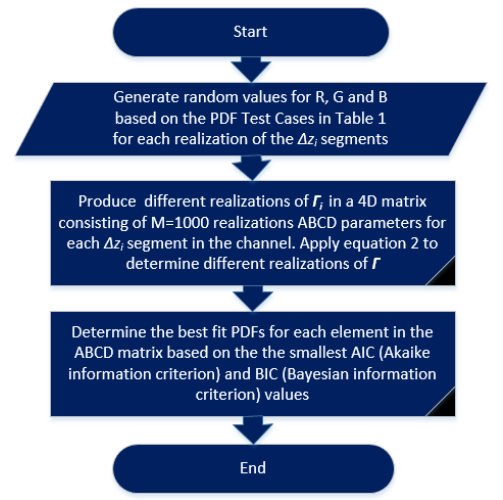
Figure 3: Algorithm implemented in MATLAB to deter- mine the resultant distributions for Γ for the different combinations of PDFs for R , G and B .